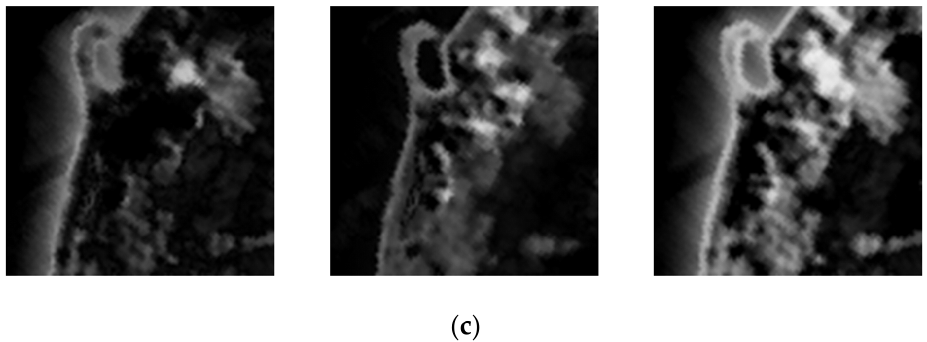
Figure 14. From left to right are ( a ) the ground-truth abundance maps; ( b ) the estimated abundance maps; ( c ) absolute error maps of soil, tree and water in Samson.